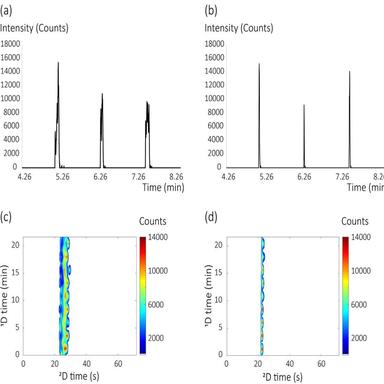
Three successive separations of caffeine in on-line LC x SFC with (a) the standard configuration and (b) the new configuration. Corresponding contour plots with (c) the standard configuration and (d) the new configuration. The two configurations are shown in 1. conditions: no column, isocratic infusion of caffeine (50 ppm in acetonitrile/water 50/50) (at 10 μL/min, T = 30 °C. 2D conditions: BEH HILIC (50 × 2.1 mm; 1.7 μm) at 1.8 mL/min, 30 °C., PBPR = 150 bar, gradient from 5% to 30%